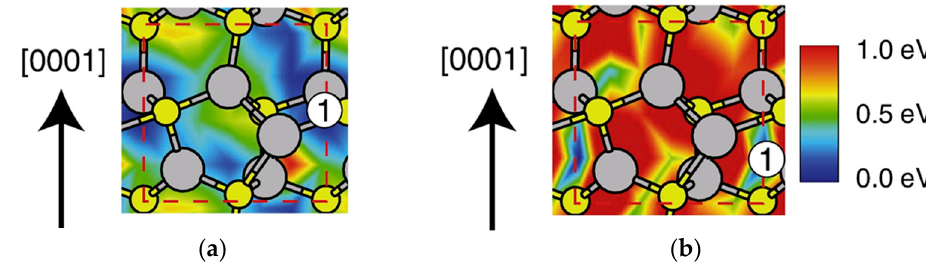
Figure 33. Calculated adsorption sites and migration barriers on the In-adsorbed ( 1120 ) surface for ( a ) In and ( b ) P atoms. Encircled numbers and contour plots represent adsorption sites and migration barriers, respectively. Large gray and small yellow circles represent In and P atoms, respectively. Reprinted with permission from [100]. Copyright (2013) by Elsevier.